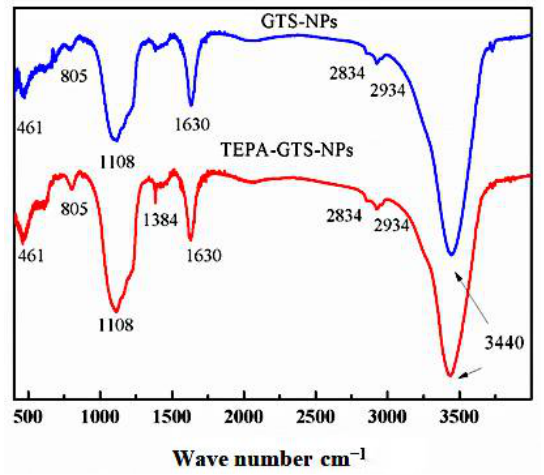
Figure 2. FT-IR spectra of GTS-NPSi and TEPA-NPSi.